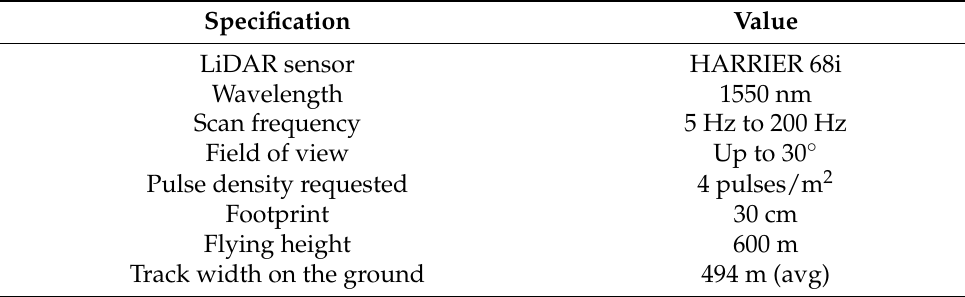
Table 1. TRIMBLE HARRIER 68i LiDAR system specifications.